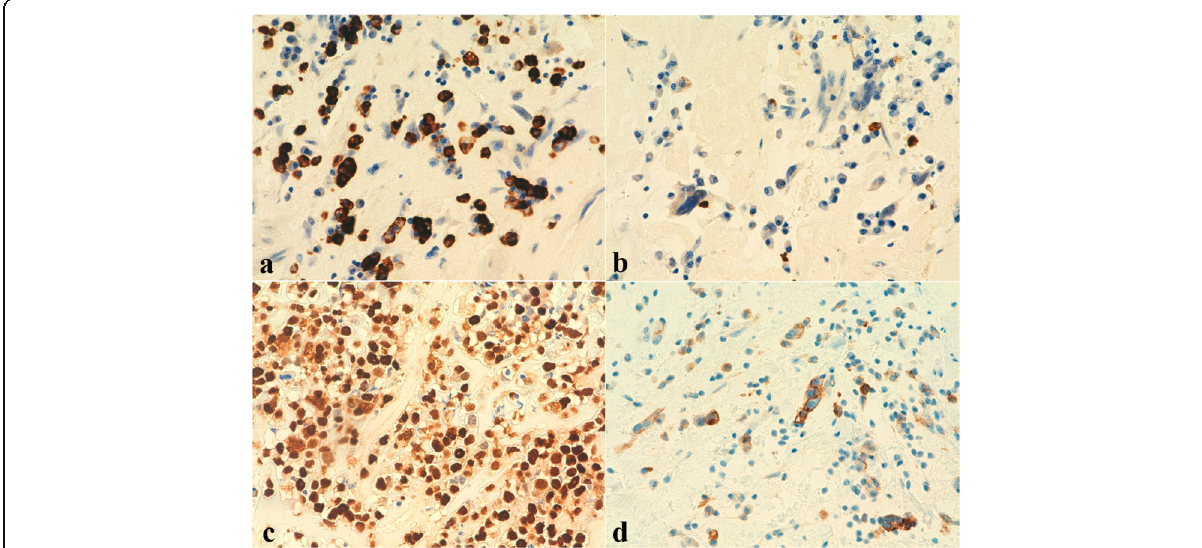
Fig. 2 a Kappa (HIS 40x) & b Lambda (HIS 40x). Malignant cells showed kappa light chain restriction. c EBV (40x). EBERs study was positive in malignant cells. d PDL1 (40x). Programmed Death-Ligand 1 (PD-L1) study showed positivity in about 60% of the malignant